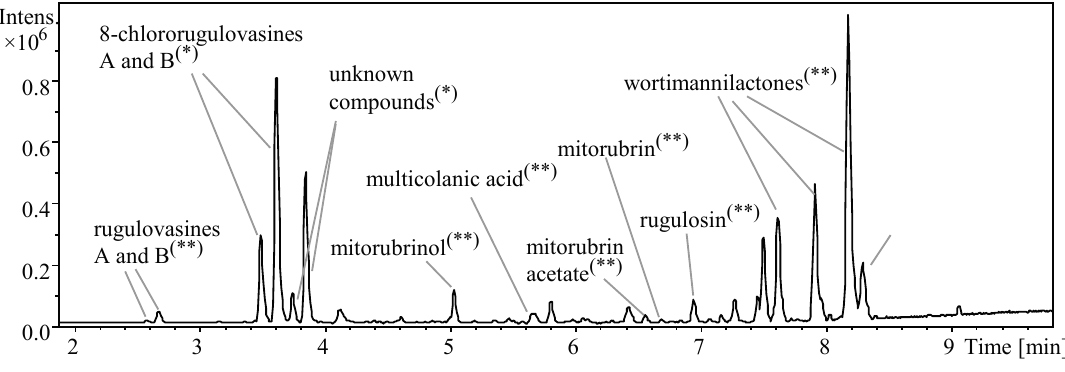
Figure 2. BPC chromatogram (100–1000 Da) from the micro-extract of T.